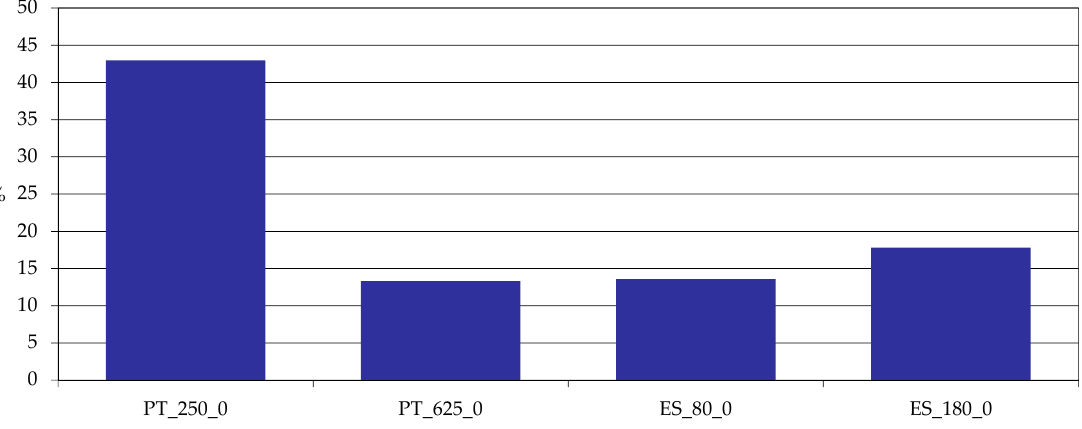
Figure 2. Profit margin whole farm (% share of farm income in total returns). Source: model results.